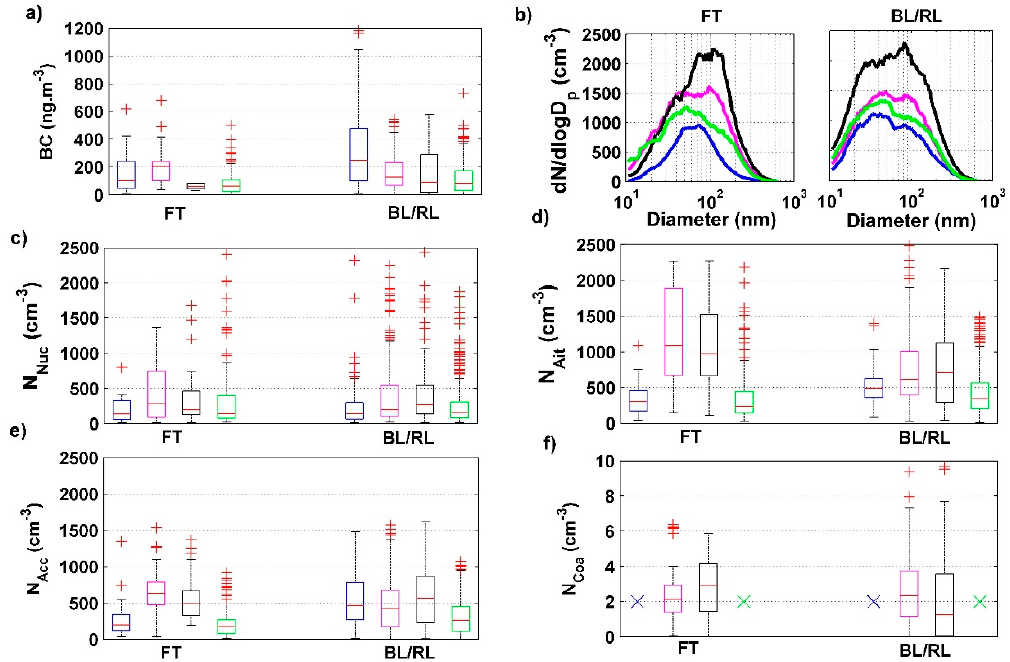
Figure 9. The FT/(BL/RL) variation of: ( a ) BC; ( b ) Full aerosol size distributions (10–650 nm); ( c ) Nucleation (Nuc) (10–20 nm); ( d ) Aitken (Ait) (40–80 nm); ( e ) Accumulation (Acc) (100–300 nm); ( f ) Coarse (Coa) (>1 μ m), concentrations for the four seasons. Red lines represent the median value, bottom and top sides of the boxes symbolize the 25th and 75th percentile respectively and the extremities of the black lines are the 10th and 90th percentile. Red Crosses represent the outliers.